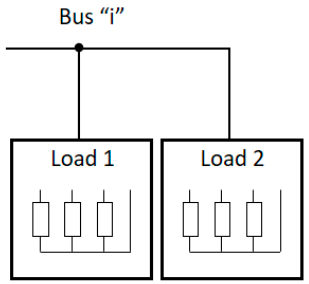
Figure 2. Two parallel non-linear loads connected to a system bus.